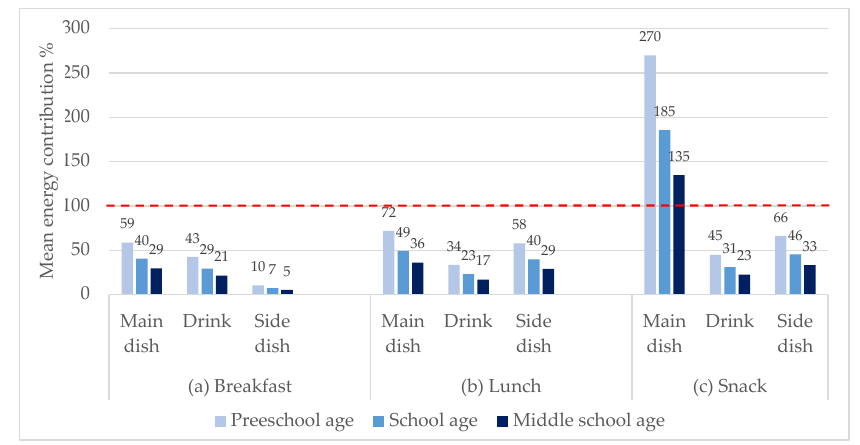
Figure 2. Percentage energy contribution of each menu item by school age per mealtime (%).